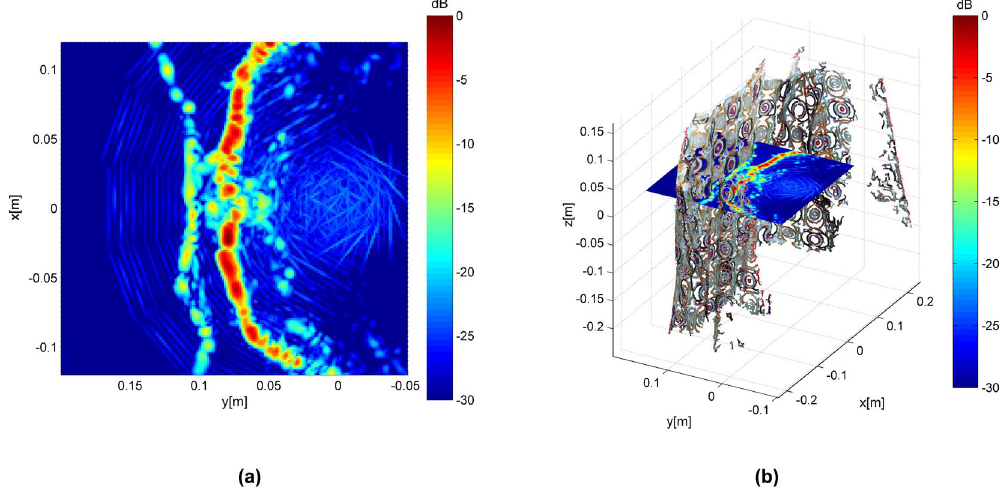
Figure 9. Reflectivity computed for a cut at z = 0 cm: ( a ) overview; ( b ) superposed dense point cloud obtained from optical